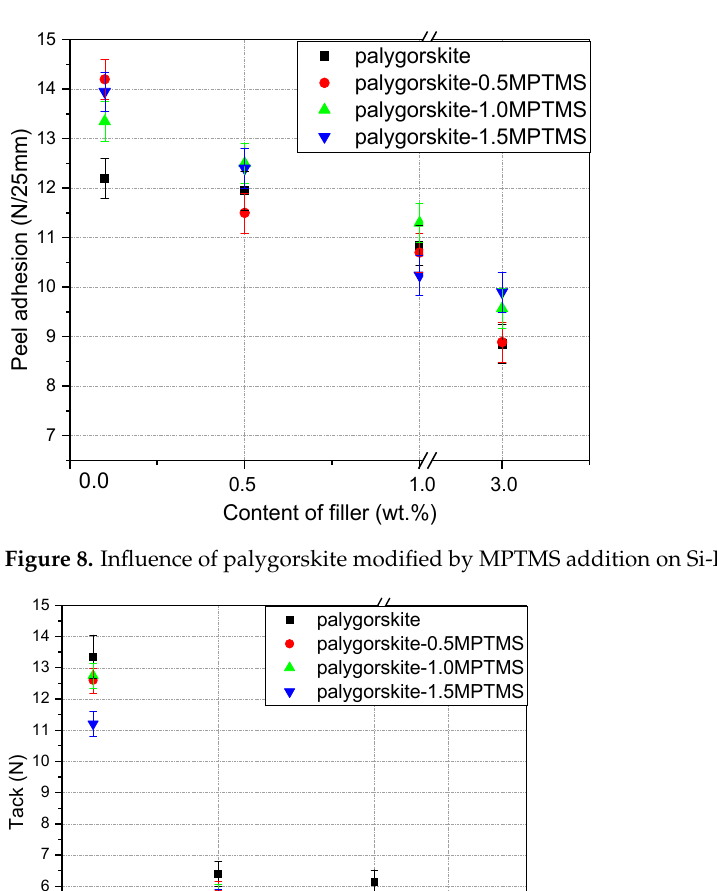
Content of filler (wt.%)